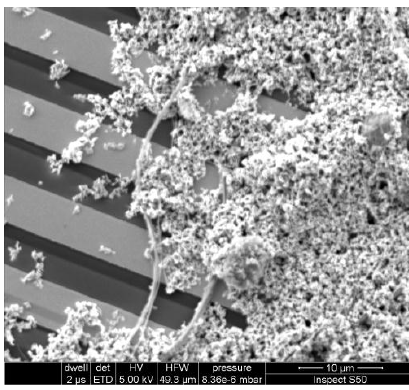
Figure 5. Scanning electron microscope (SEM) image of the distribution of ZnO nanostructures on the interdigital